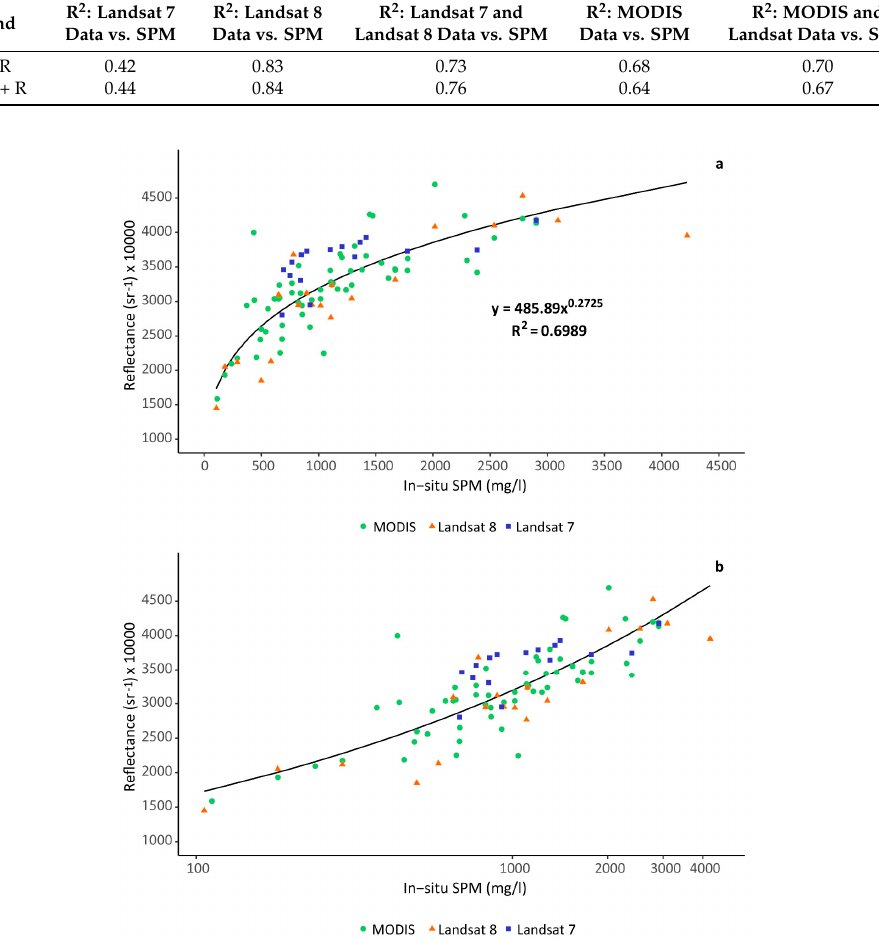
Figure 3. Daily MODIS and Landsat 7 and 8 NIR bands as a function of SPM in ( a ) linear and ( b ) log x -axis scale (N = 60 for MODIS data and N = 37 for Landsat data). R 2 indicates the Pearson’s correlation.